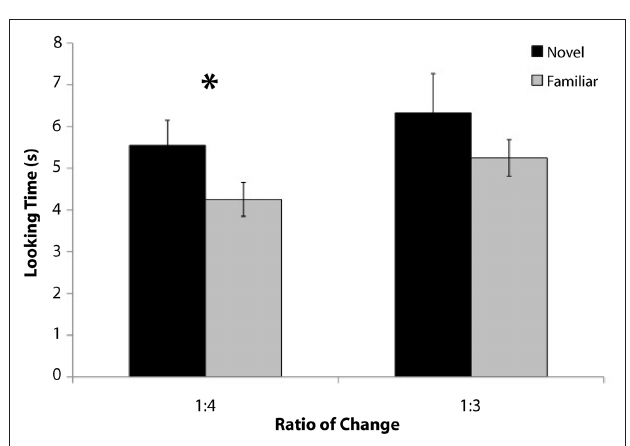
Figure 4 | Mean looking times during the three familiar and three novel test trials for infants in experiment 2 (number constant in